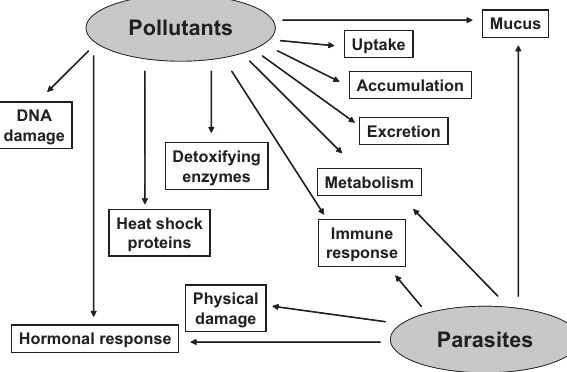
Fig. 1. – Organism’s response against isolated pollution or parasi- tism (modified from Hofer & Lackner,